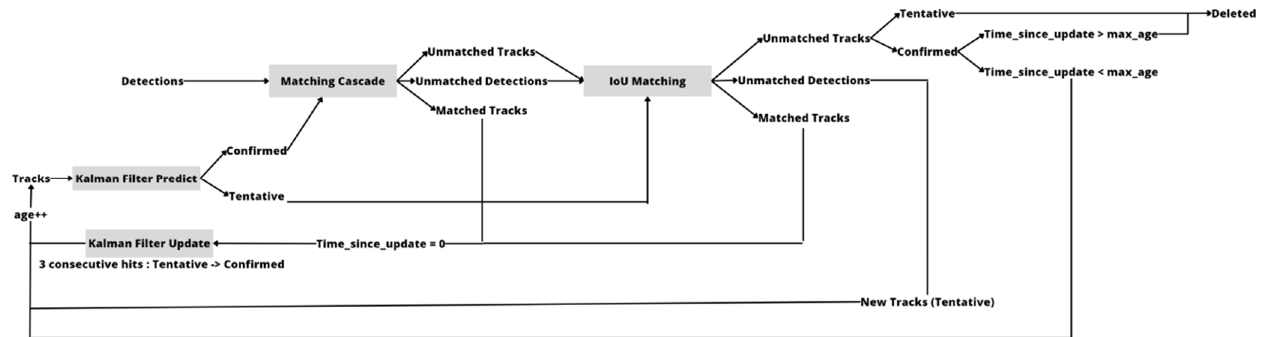
Figure 3. Overview of the object tracking Deep-SORT algorithm.